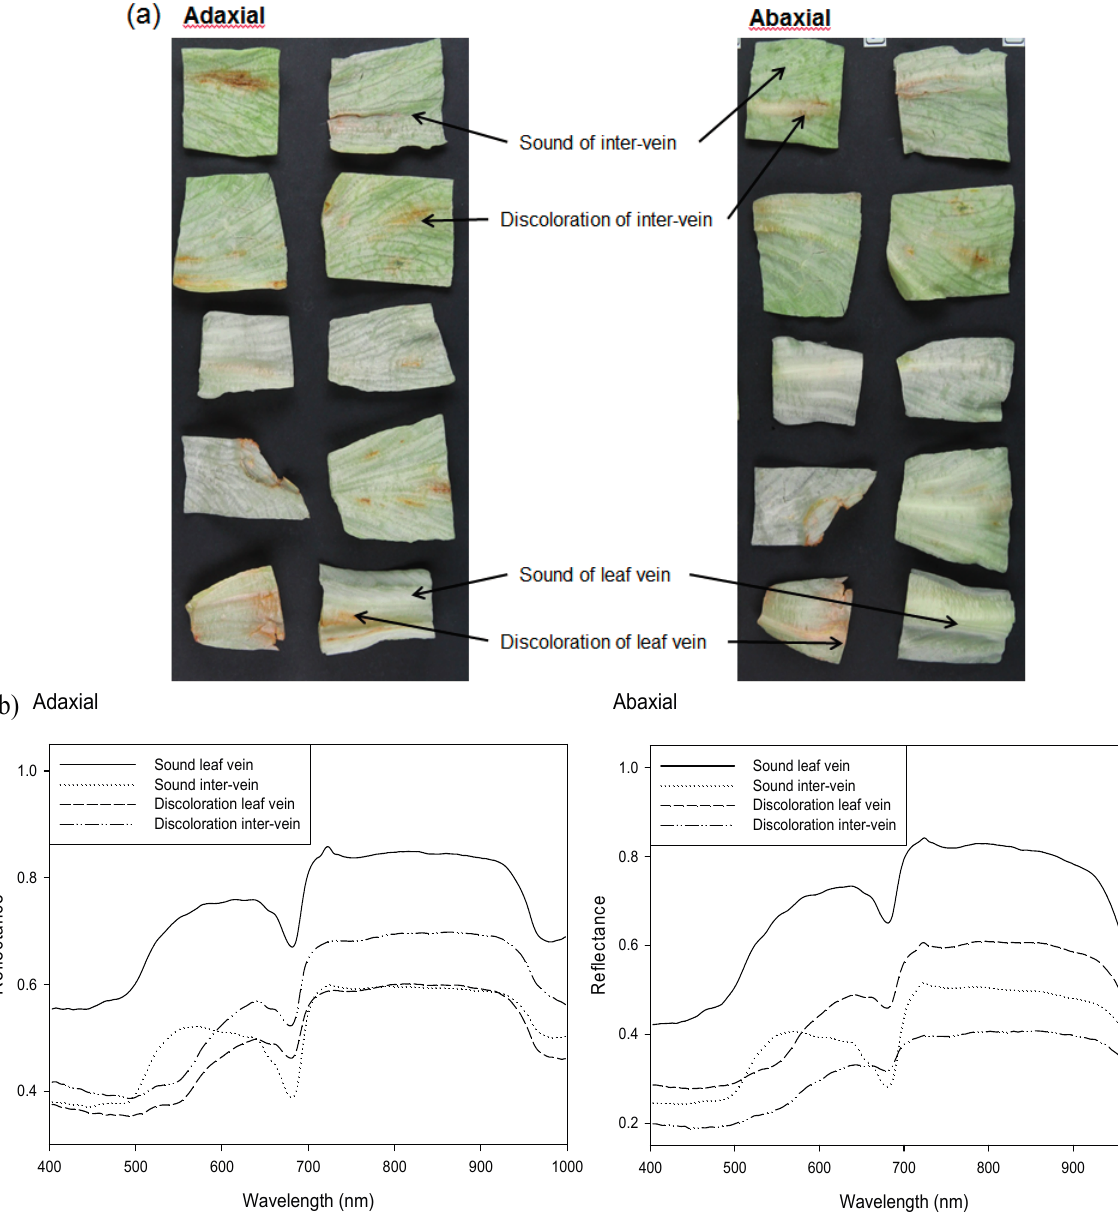
Figure 2. ( a ) Images of lettuce leaves and ( b ) representative reflectance spectra of discolored and sound areas on the veins and inter-vein regions of adaxial and abaxial lettuce leaf